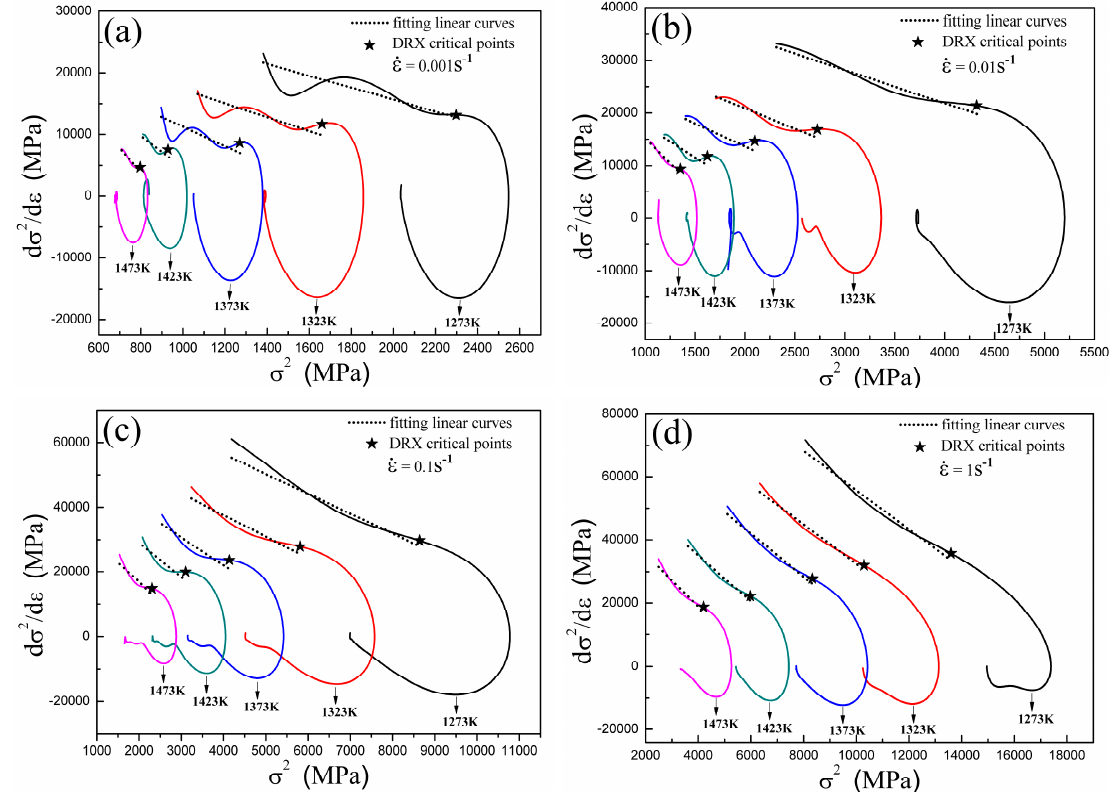
Figure 3. d σ 2 / d ε vs. σ 2 plots derived from the true stress-strain curves of Armco-type pure iron: ε = 0.001 s − 1 ; ( b ) ε = 0.01 s − 1 ; ( c ) ε = 0.1 s − 1 ; and ( d ) ε = 1 s − 1 . The part before the DRX critical point of each curve refers to the DRV process and is fitted by the linear curve of the dot line. These linear curves are employed to determine the values of k and σ rs . The method to determine the DRX critical points will be discussed later.